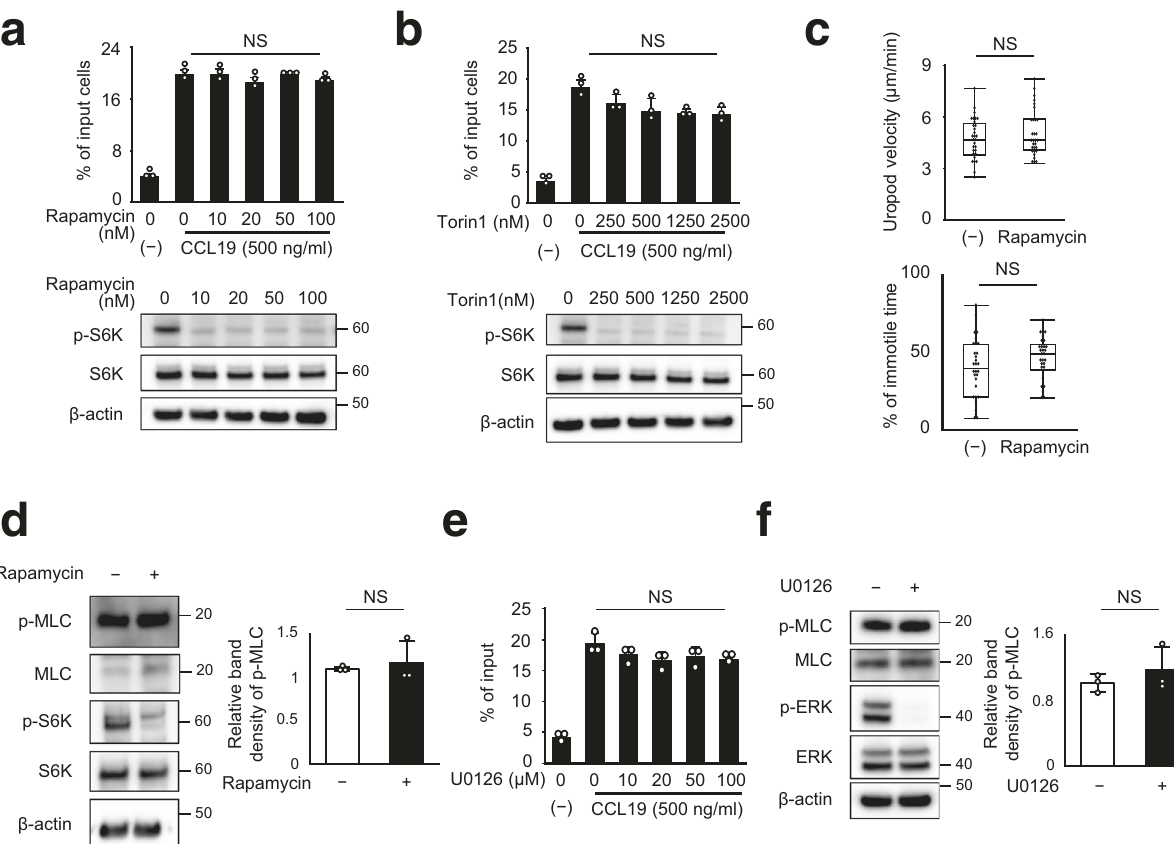
Fig. 3 mTOR inhibition does not affect DC migration. a , b Chemotaxis of DCs treated with mTORC1 inhibitors in response to CCL19. Chemotaxis of WT BMDCs in response to CCL19 (500 ng/ml) in the presence of the indicated concentration of rapamycin ( a ) and torin1 ( b ), as determined by Transwell assay (pore size, 5 μ m) (upper). Data are representative of three experiments (mean± s.d.). Phosphorylation of S6K following treatment with rapamycin ( a )